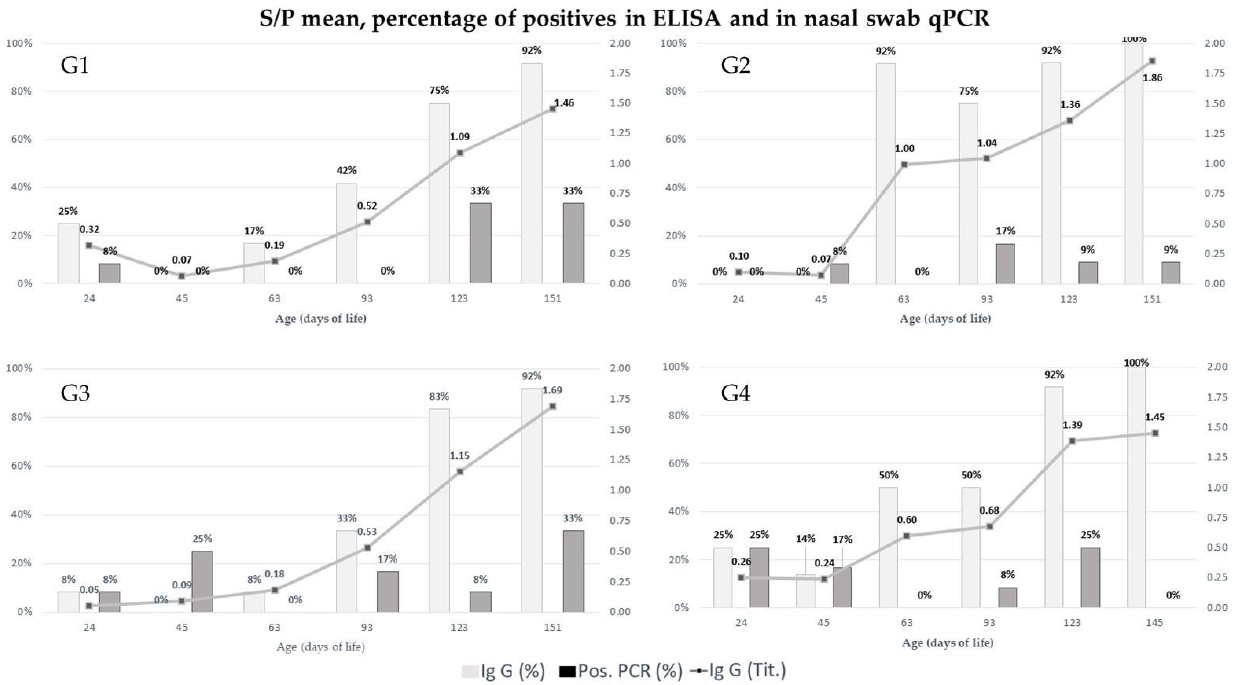
Figure 1. Mean value and percentage of serologically positive animals in the different groups (ELISA S/ P value) for IgG anti- M. hyopneumoniae and prevalence of positive animals in nasal swab qPCR. When comparing the S/ P values between repeated measures over time for each group, it was observed that for G1 at 24 days the antibody titer did not differ from the others. At 45 days, the antibody titer was lower than those at 123 and 151 days. At 151 days of age, there was no difference compared to 45 and 63 days, which did not differ from the other points ( p = 1 × 10 − 4 ). For G2, the medians of S/ P recorded at 123 and 151 days were higher than at 24 and 45 days. At 63 and 93 days, there were no differences between them or among other points ( p = 2.8 × 10 − 5 ). In G3, differences were also observed between the values at 123 and 151 days compared to 24 and 45 days, while the other points did not differ from each other or from the others ( p = 9.8 × 10 − 5 ). Finally, in G4, the S/ P values at 123 and 151 days were higher than those at 24, 45, and 63 days, which did not differ, and at 93 days, no differences were observed when compared to the other time points. At 45 days of age, no serum sample was positive for anti- M. hyopneumoniae IgG. In G2, no animal was positive until 63 days of age, the moment of the highest percentage of seroconversion for G2 at this time of collection when compared to the other